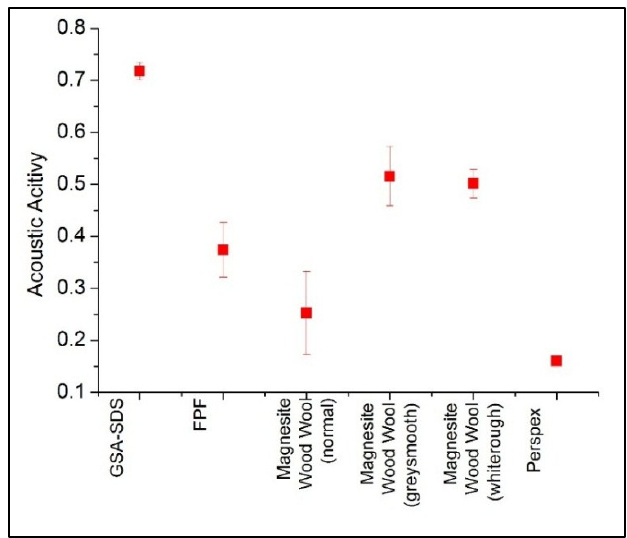
Figure 7. Normalized acoustic absorption coefficient (acoustic activity) of selected